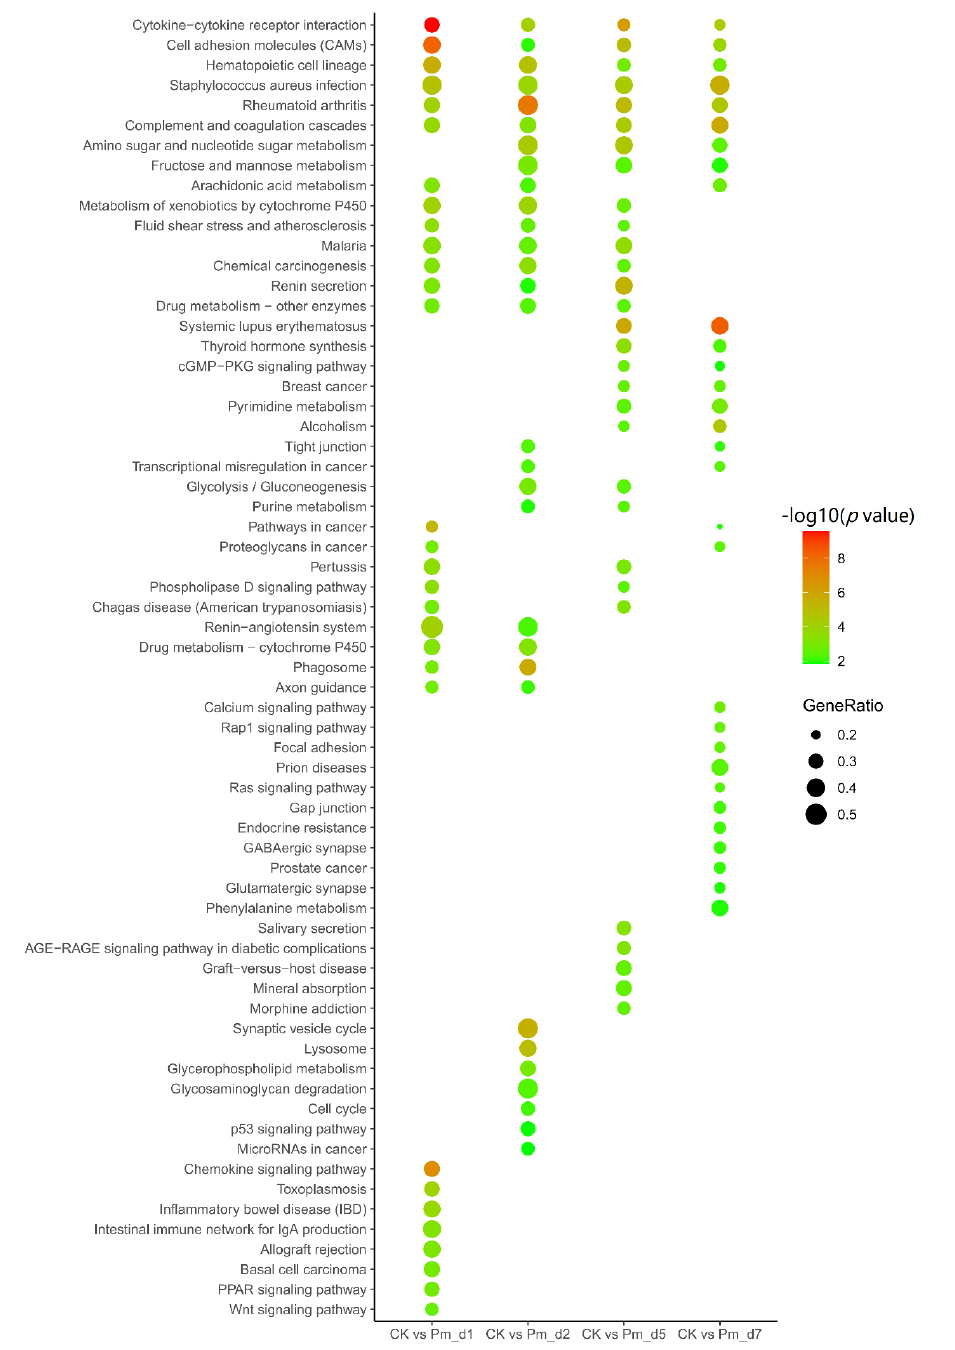
Figure 5. Top 30 enriched KEGG pathways for DEGs in the lung tissues of Pm–challenged goats 1 day, 2 days, 5 days and 7 days compared with the CK group. The x-axis indicates the compared groups, while the names of the GO terms are shown on the y-axis. The size and color of the dot indicate the gene ratio (the number of differentially expressed genes/total genes for each GO term) and the − log 10 ( p -value) (Fisher’s exact test),